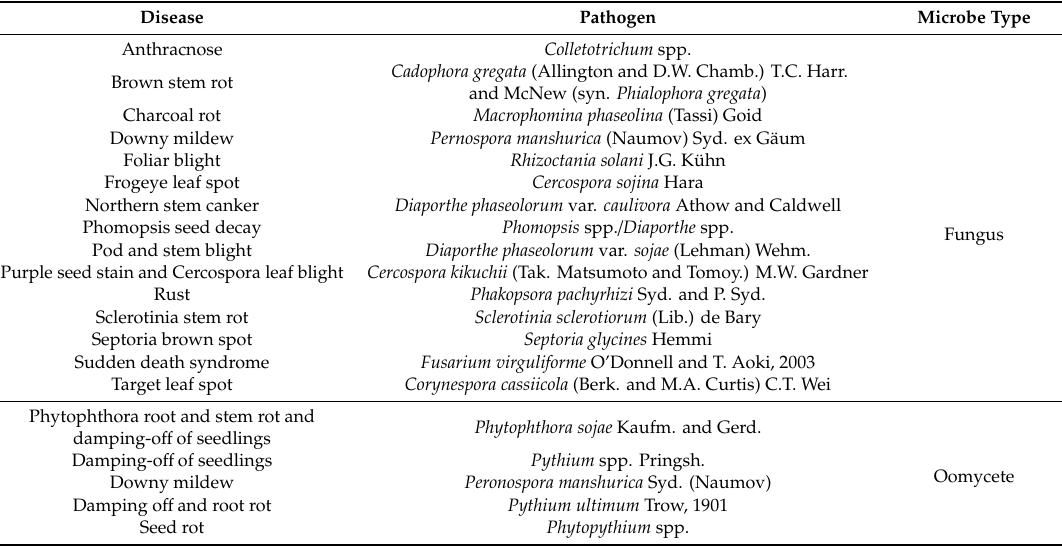
Table 1. Common soybean diseases caused by fungi, oomycetes, bacteria, or viruses. Disease